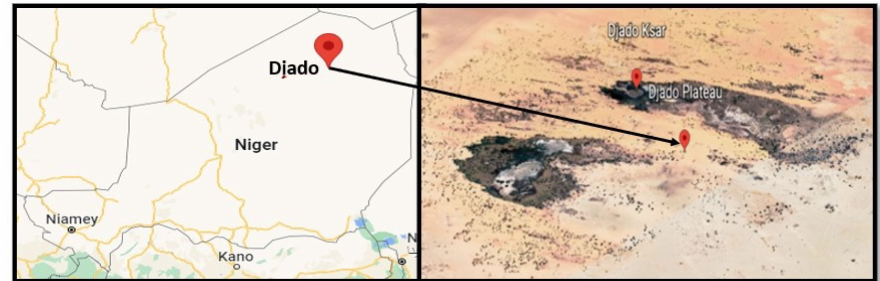
Figure 2. Djado Plateau, Niger (21°00 (cid:48) 54 (cid:48)(cid:48) N, 12°18 (cid:48) 27 (cid:48)(cid:48)